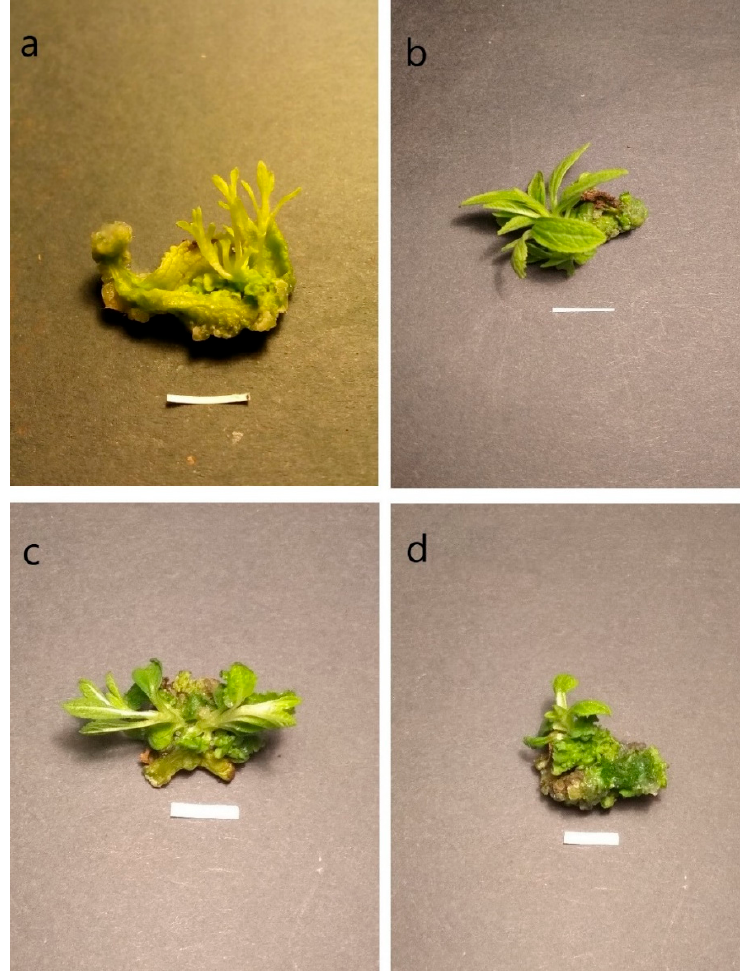
Figure 1. Regeneration of S. bulleyana through indirect organogenesis on MS medium with 0.1 mg/L NAA and 2 mg/L BAP ( a ), 0.1 mg/L NAA and 2 mg/L mT ( b ) and direct organogenesis on MS medium with 0.1 mg/L NAA and 0.2 mg/L TDZ ( c ) and 0.1 mg/L NAA and 4 mg/L CPPU ( d ) after 5 weeks. Bar 1